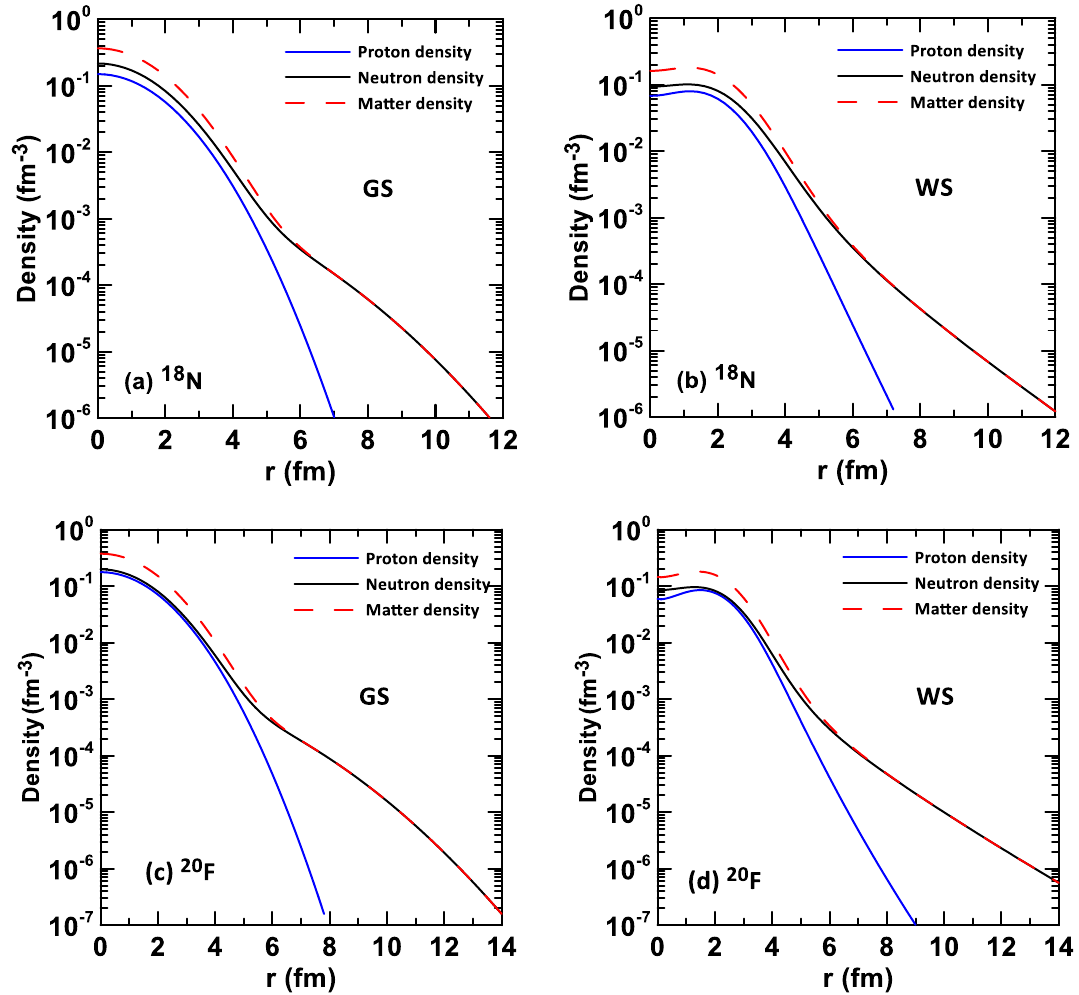
Figure 2: The , and distributions for 18 N and 20